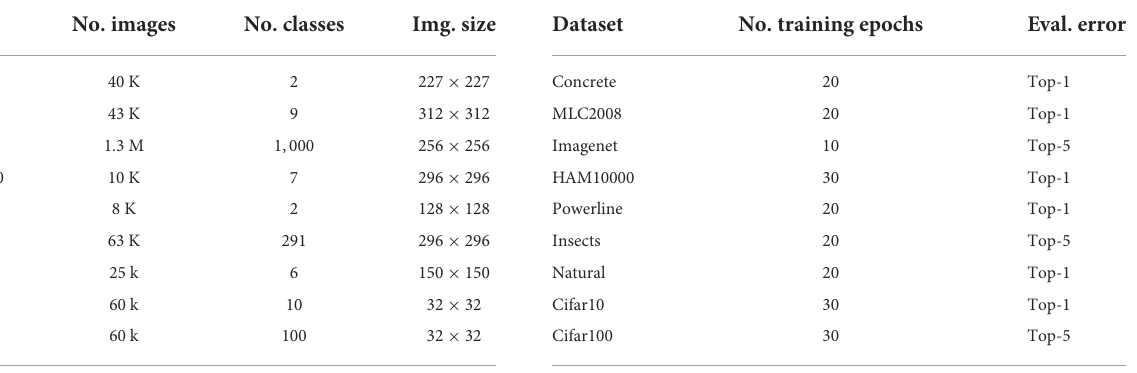
TABLE 1 Meta data of the used datasets. TABLE 2 Dataset-specific experimental